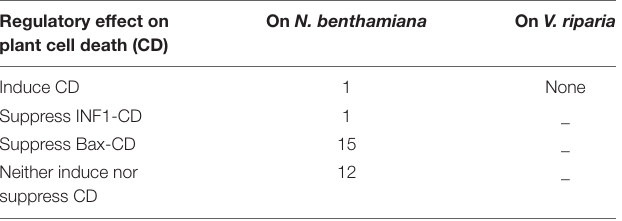
TABLE 4 | A summary of plant cell death regulation by PvCRN